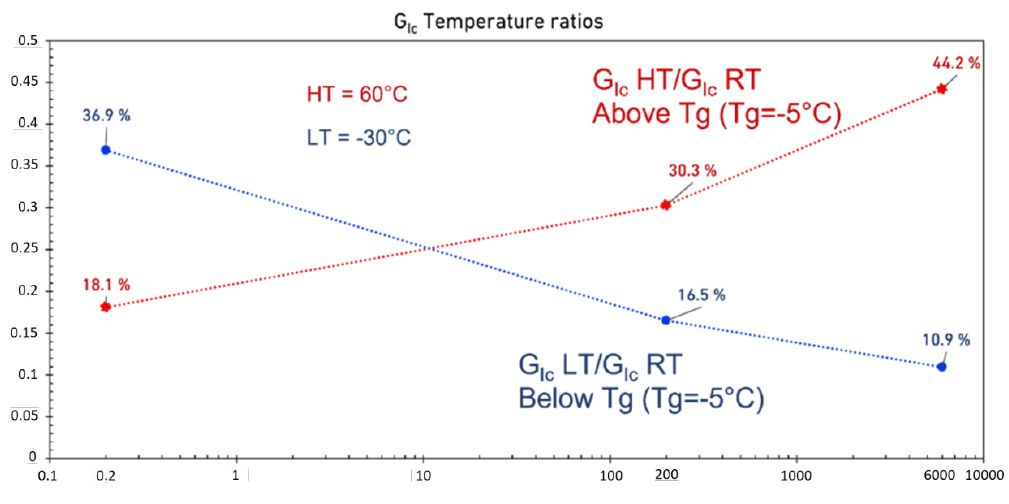
Figure 10. Mode I fracture energy temperature ratios between both HT and RT (red curve), and LT and RT (blue curve).